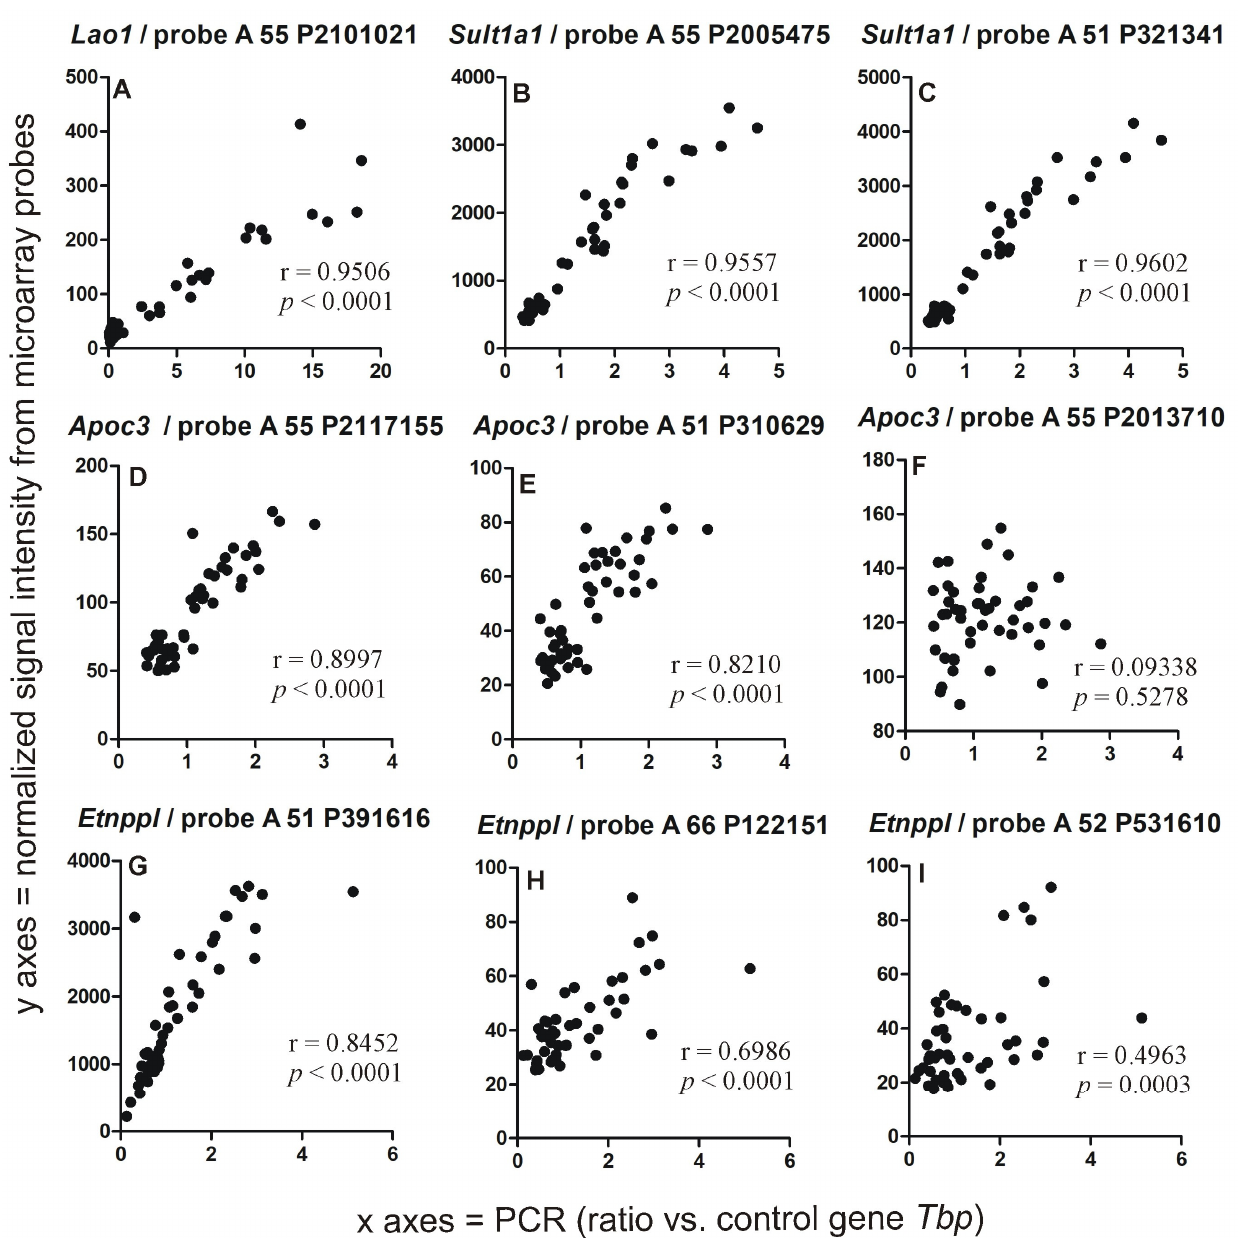
Figure 2. Correlation between results obtained with PCR and microarrays calculated separately for each probe annotated to tested genes Lao1 ( A ), Sult1a1 ( B , C ), Apoc3 ( D – F ) and Etnppl ( G – I ). The microarray signal was normalized and decomposed into single channels as described in the methods section. r—Pearson’s correlation